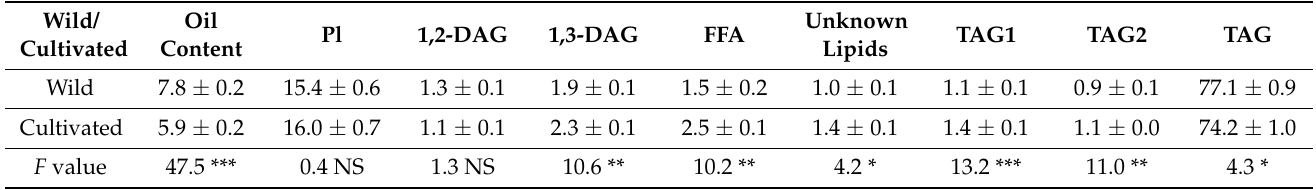
Table 1. Oil (percent of dry weight seed) and lipid content (percent of total lipid) in wild and cultivated oats samples [34].